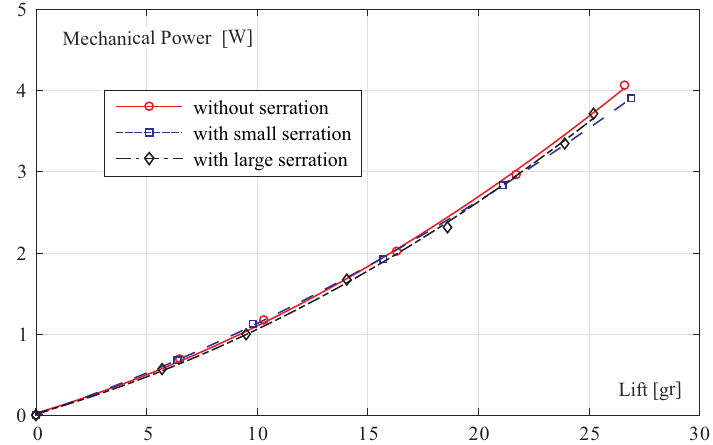
Figure 9. Mechanical power P m vs. lift L for the wings with trailing edge serration.